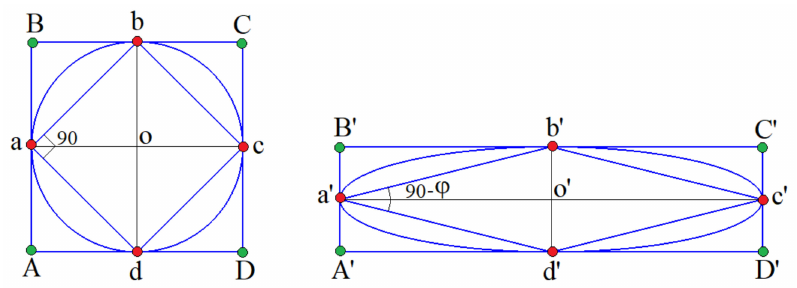
Figure 19. Schematic illustration of pure shear during symmetric rolling.